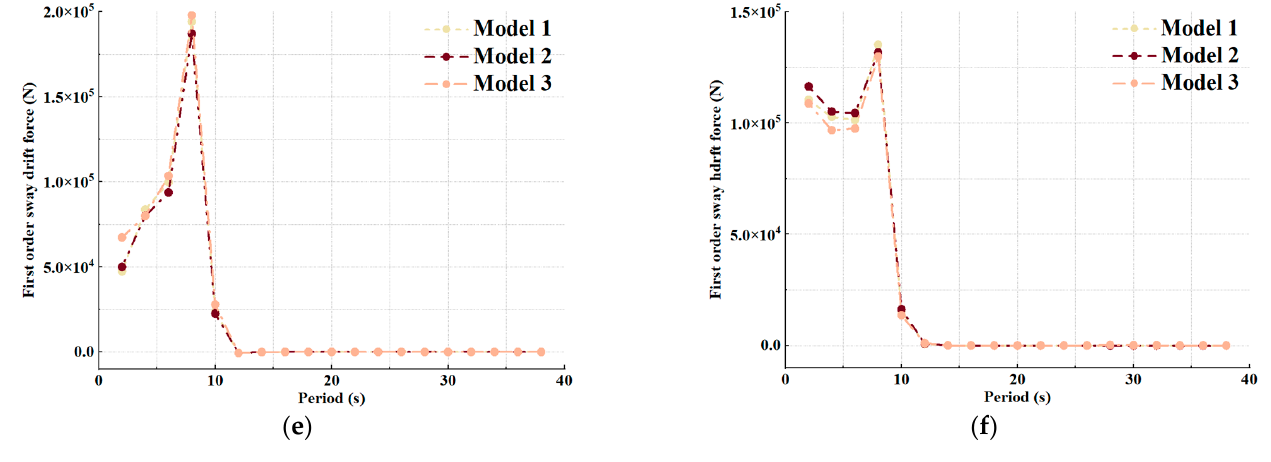
Figure 5. Mesh convergence verification. ( a ) First-order heave motion; ( b ) First-order pitch motion; ( c ) First-order roll motion; ( d ) First-order roll moment; ( e ) Mean drift force in the sway by the far-field method; ( f ) Mean drift force in the sway by direct pressure integral method.